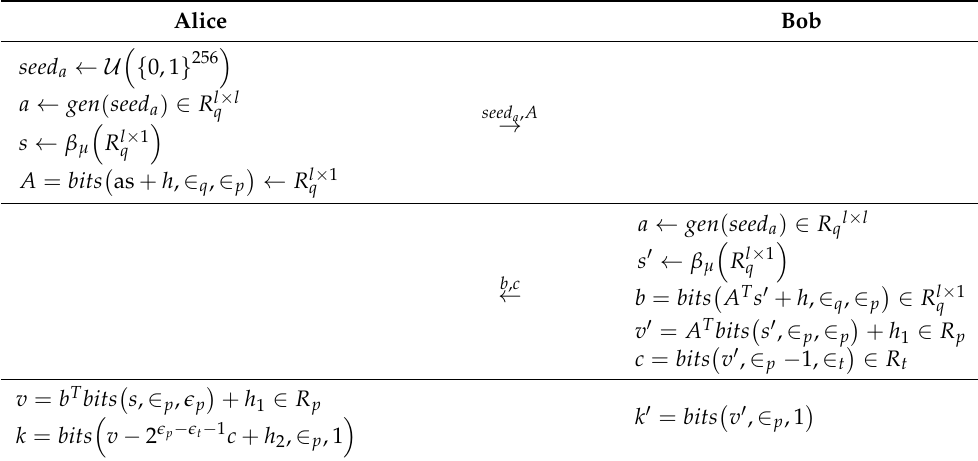
Table 1. Saber key exchange